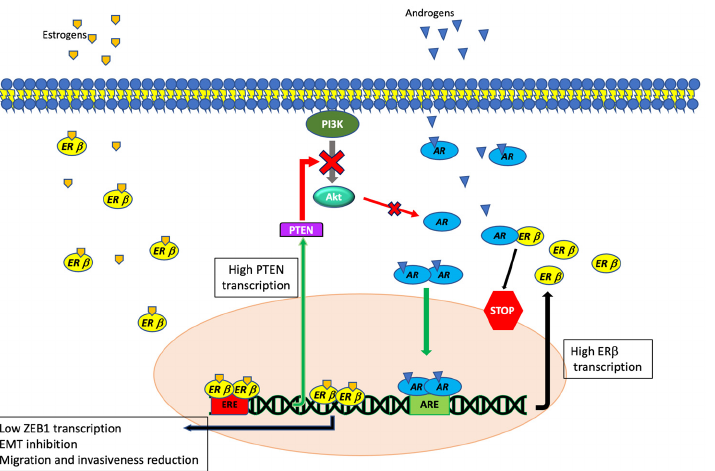
Figure 3. Schematic representation of ER β activated pathways and their interactions with AR-dependent signaling in TNBC. By reducing ZEB1 levels, ER β negatively controls cell migration and EMT in AR-positive TNBC. AR controls the ER β -mediated transcription by binding androgen responsive elements (ARE) localized into the ER β promoter, while ER β inhibits AR by increasing the PTEN protein level and inhibiting the AR nuclear translocation.